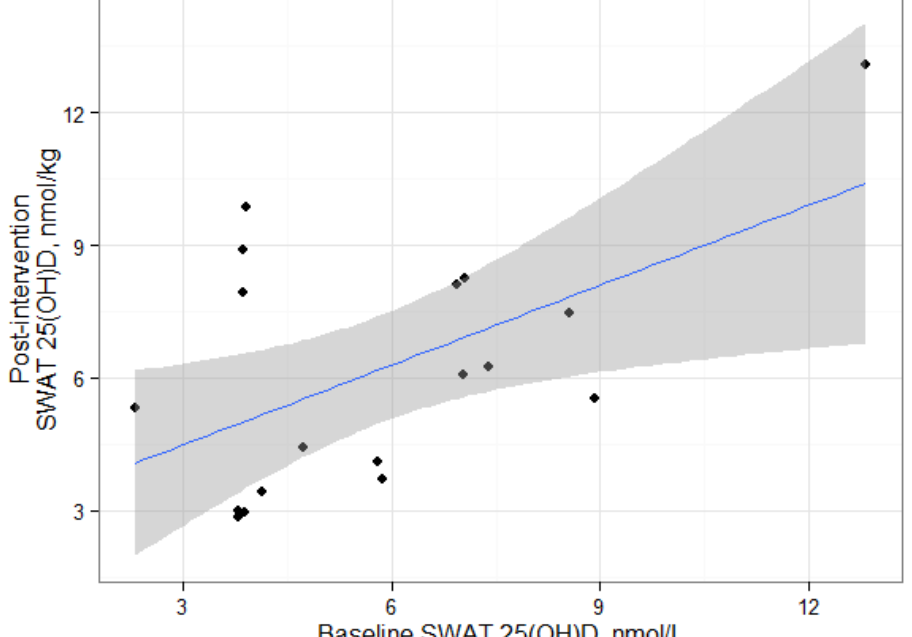
Figure 2. Association between Subcutaneous White Adipose Tissue 25(OH)D and Post-Intervention in adults who participated in a 15 week weight loss trial. Shaded line = 95% Confidence